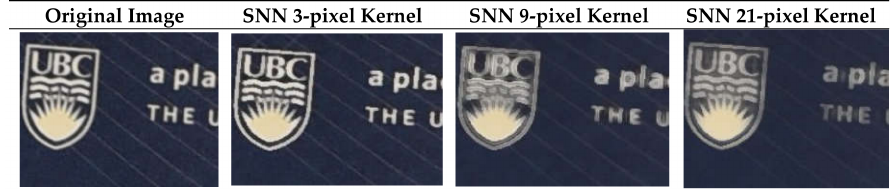
Figure A5. Comparison of the results between the original image from region D in Figure A1 to cases where the Symmetric Nearest Neighbor (SNN) filter was applied with neighborhood sizes of 3, 9, and 21-pixel